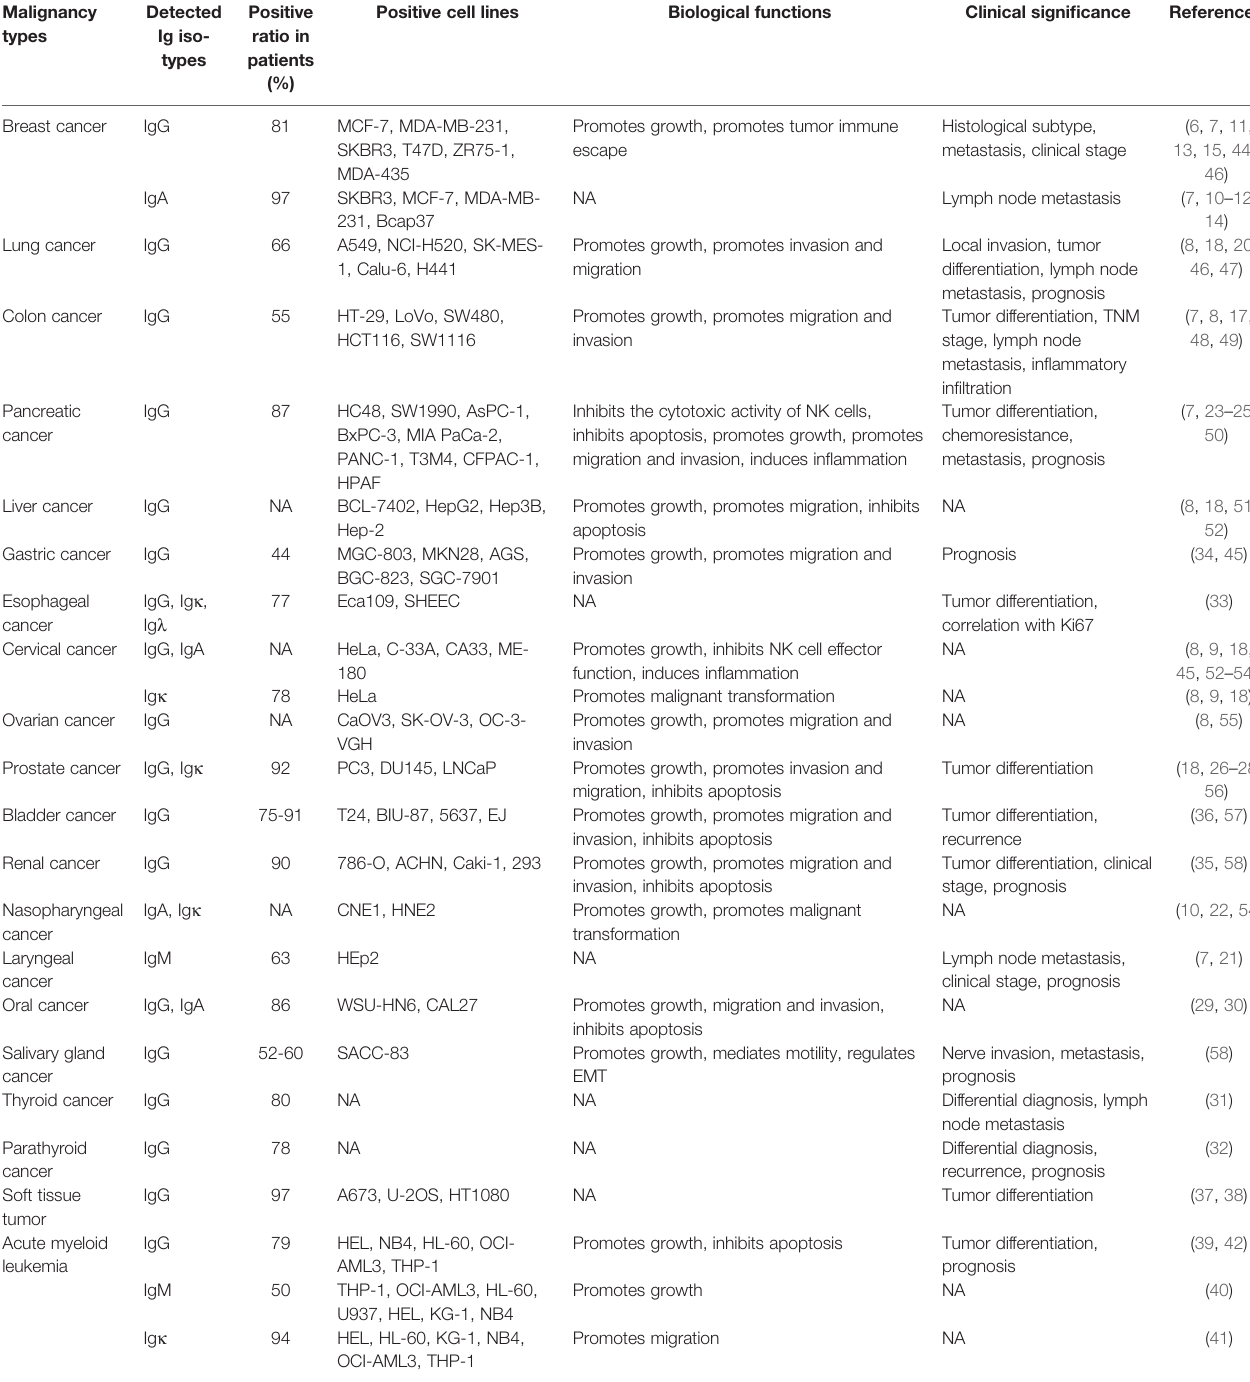
TABLE 1 | Cancer-derived Ig expression in different types of